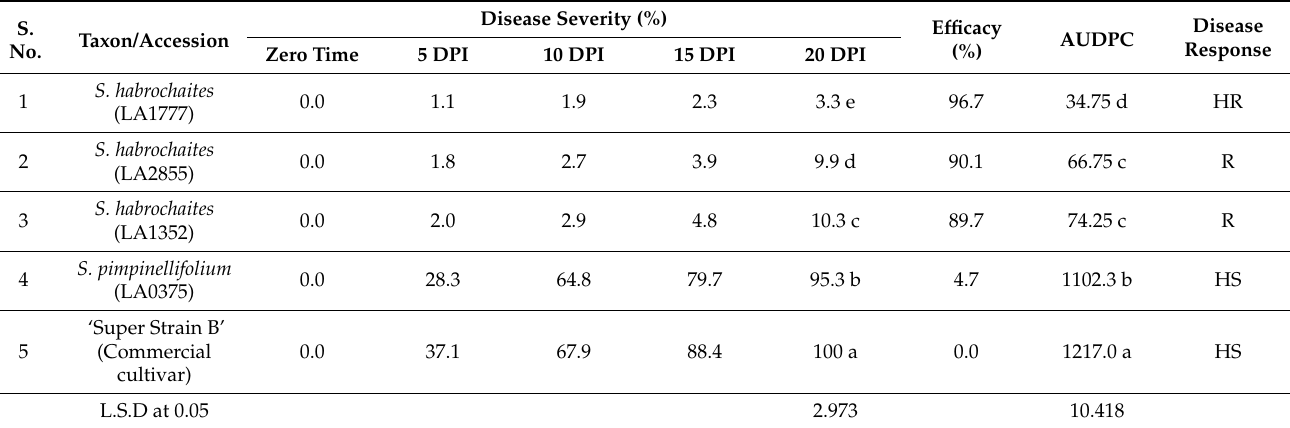
Table 2. Disease severity of late blight for five tomato genotypes inoculated with P. infestans isolate EG_7 under controlled conditions. Results from 2021 1 .